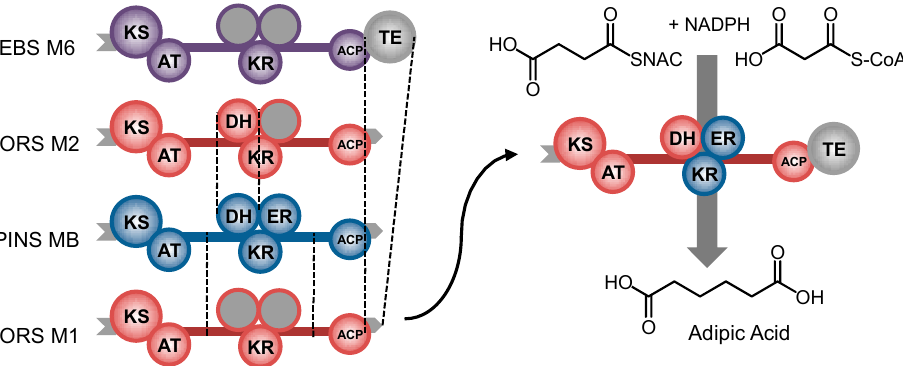
Figure 9 . Procedure undertaken by Hagen et al. to develop an adipic acid-producing PKS module. Dashed lines denote the multiple junctions tested for each loop and domain swap.